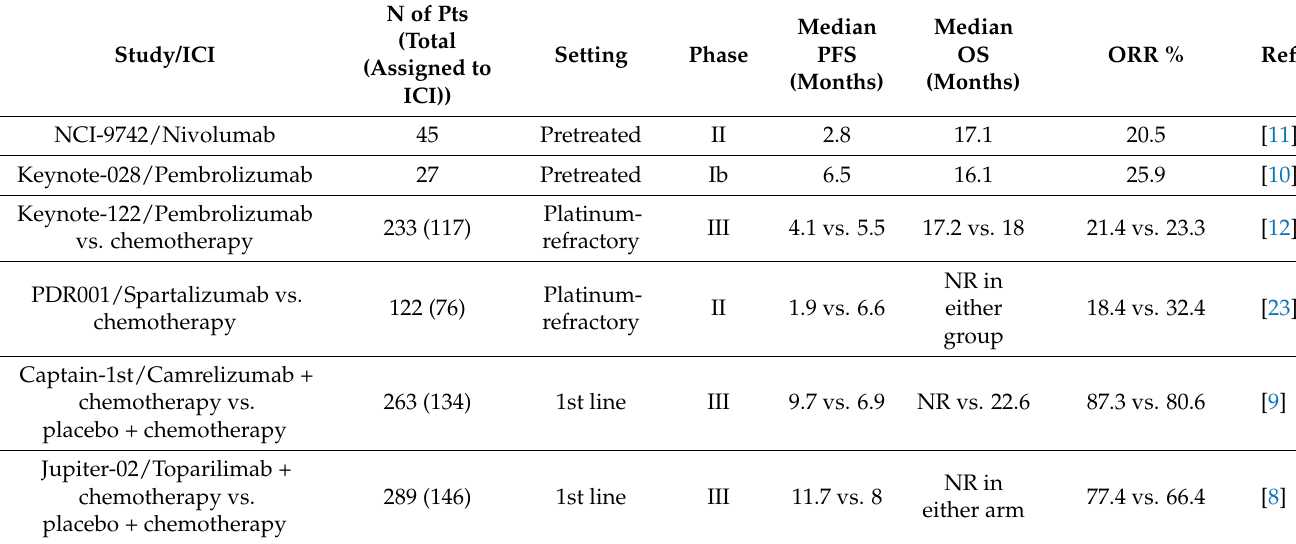
Table 3. Anti-PD-1 studies in R/M NPC. Abbrev: ICI = Immune Checkpoint Inhibitor, NPC